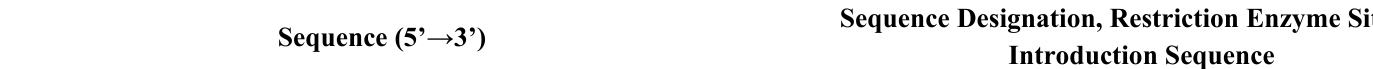
Table 1. Primers used for generating pBAC-C-KCE, donor plasmid pRThGA and identification of the